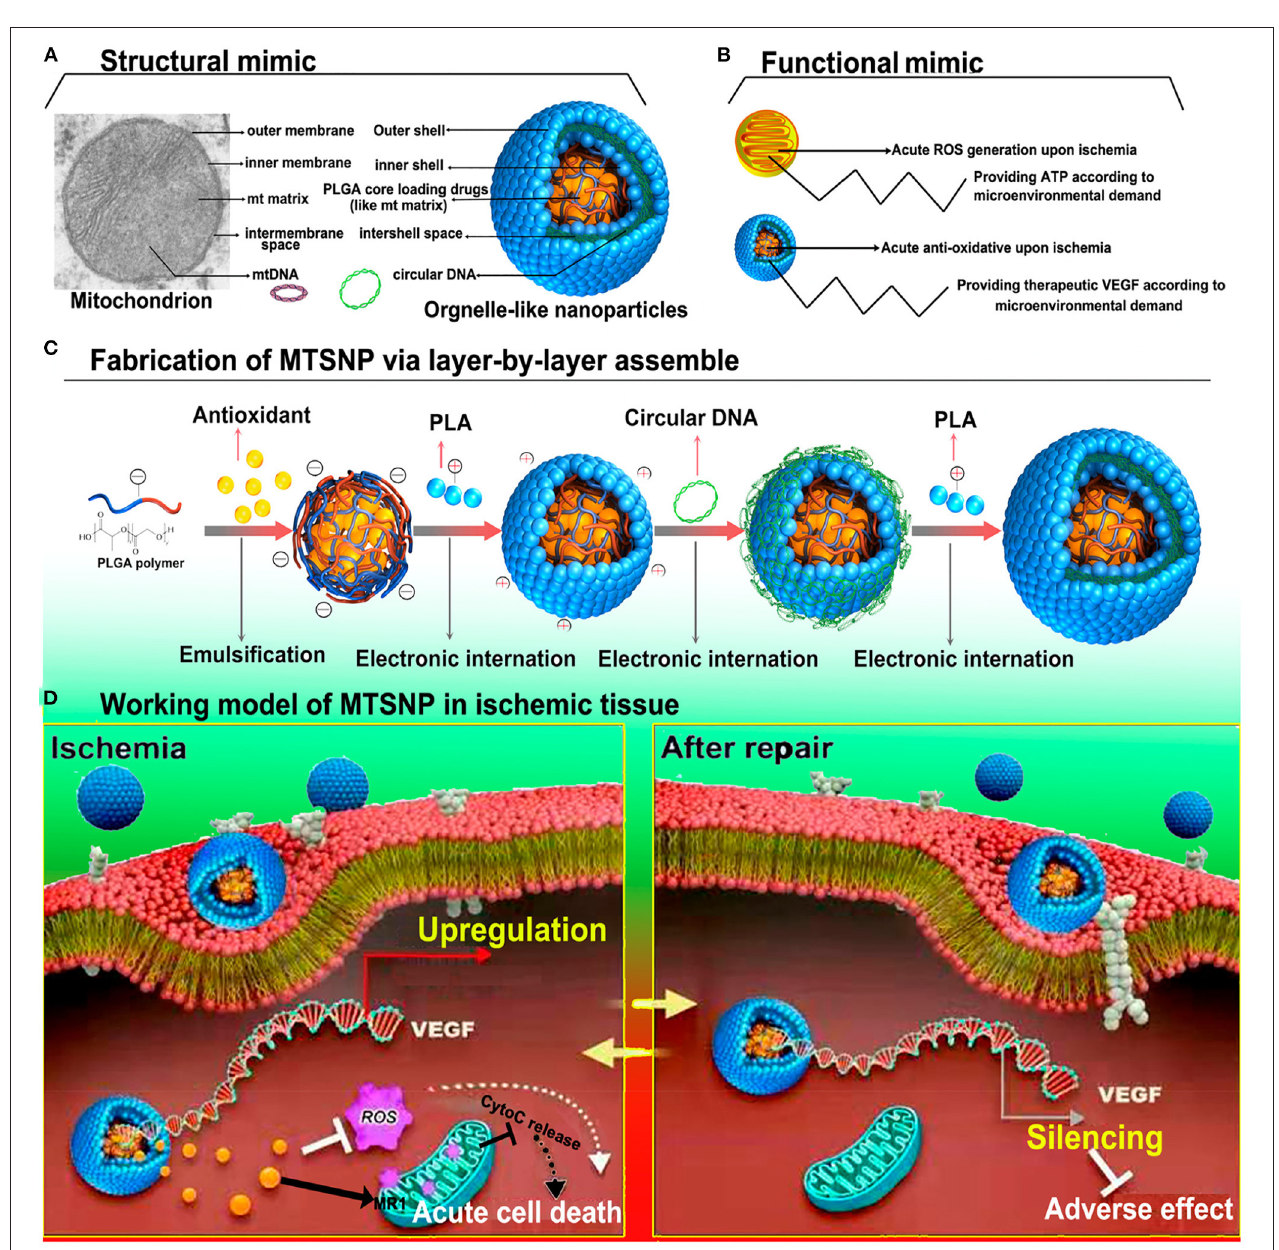
FIGURE 2 | Schematics representing the fabrication of mitochondria mimicking smart polyelectrolyte nanoparticle and their mechanism of action. (A) Structural mimic of organelle-like nanoparticle, (B) Functional similarity of the mitochondrion and organelle-like nanoparticle. (C) Fabrication of organelle-like nanoparticles by layer-by-layer approach. (D) Ischemia responsive activation of VEGF expression facilitated organelle-like nanoparticle and their antioxidant potential (70).